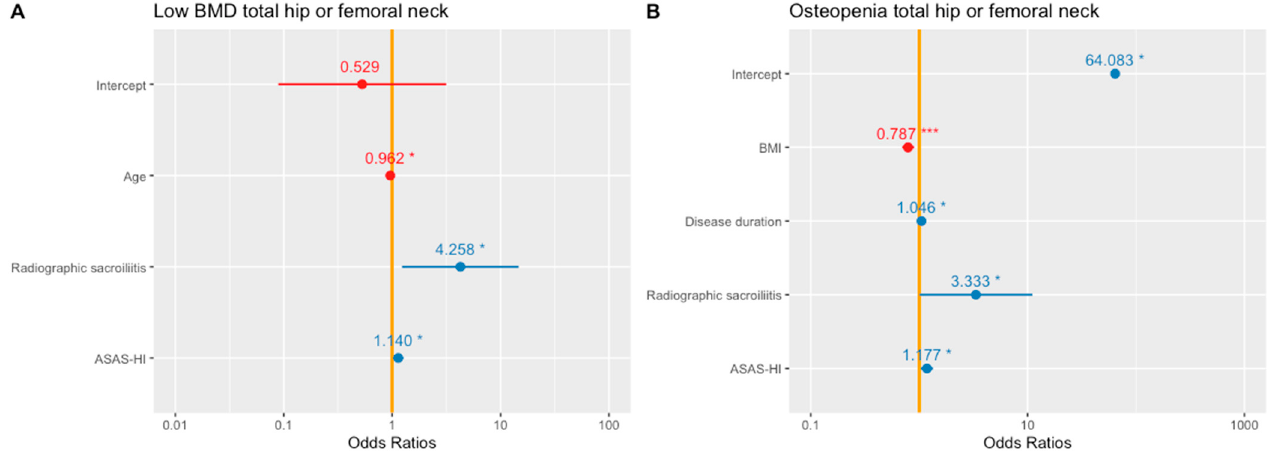
Figure 1. Multivariate logistic regression to evaluate the factors associated with low BMD ( A ) and osteopenia ( B ) in the total hip or femoral neck. ASAS-HI: ASAS Health Index; BMI: Body Mass Index. *, p - value < 0.05; ***, p -value < 0.001